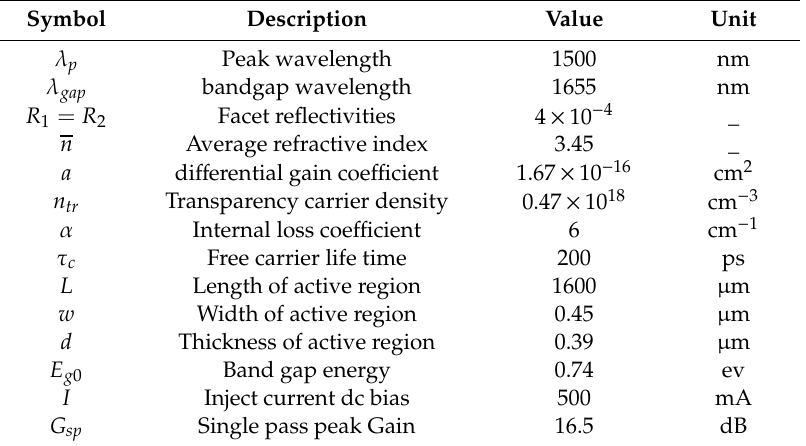
Table 1. SOA geometrical and material parameters used in the